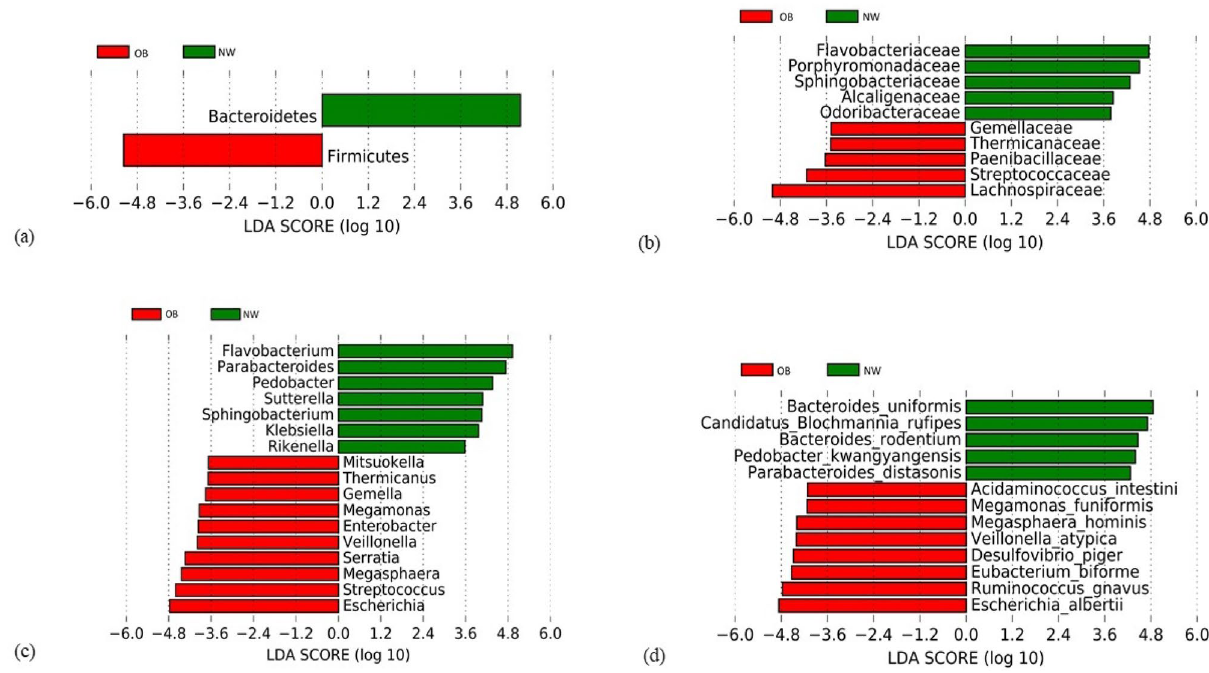
Figure 3. Linear Discriminant Analysis Effect Size (LEfSe) of microbial taxa between OB and NW. LEfSe plots of taxonomic biomarkers were generated on Galaxy computational tool v.1.0. (https ://hutte nhowe r.sph.harva rd.edu/galax y/). Results were ranked by their Linear Discriminant Analysis (LDA) score. Red bacterial taxa were more abundant in OB; green bacterial taxa were more abundant in NW. NW = normal-weight healthy controls, OB = overweight and obese patients; ( a ) Phylum level, ( b ) Family level, ( c ) Genus level, ( d ) Species